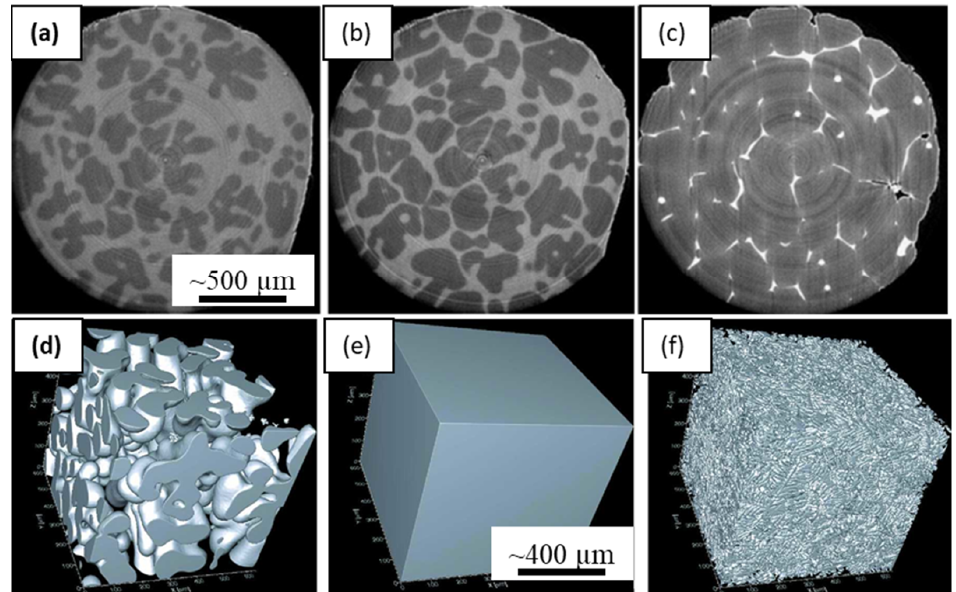
Figure 5. In situ tomographic capture solidifying microstructures: ( a – c ) Reconstructed slices of tomographic scans captured during solidification of Al-4wt%Cu alloy, showing microstructure evolution in real-time. The light grey shows liquid and the dark phase represents solidifying microstructures, after Salvo et al., [101] (Reproduced from Salvo et al., 3D imaging in material science: Application of X-ray tomography. Comptes Rendus Phys. 2010, 11, 641–649. Copyright © 2021, Elsevier Masson SAS, All rights reserved); ( d – f ) 3D reconstructed views of melting and solidification sequence of Al-20 wt.% Cu alloy performed using a laser-based furnace (after Fife et al., [21]). Permitted for reuse from respective publishers.